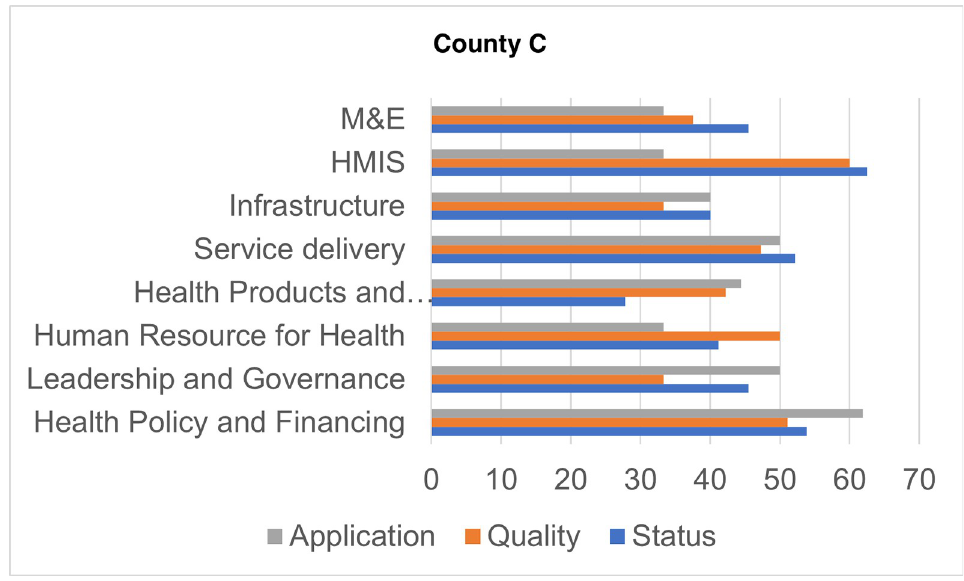
Fig 3. Scores by dimension of assessment, County